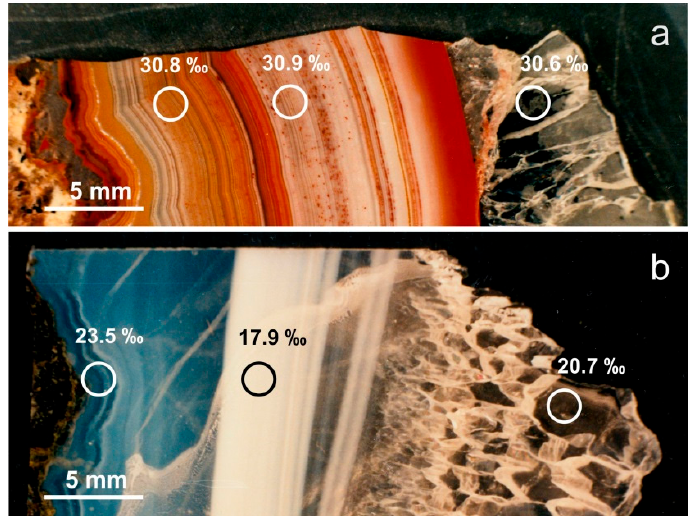
Figure 19. Hydrothermal vein agate from Schlottwitz, Germany ( a ) and agate from mafic lavas of the Ardownie quarry, Scotland ( b ) with results of spatially resolved oxygen ‐ isotope analyses (circles).